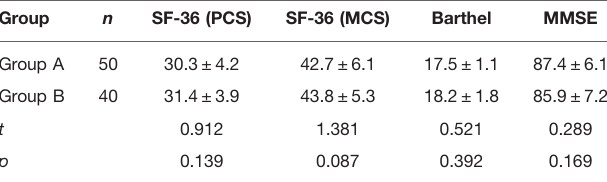
TABLE 6 | Comparison of life quality and mental state at 12 months postoperative between two group (score, (cid:1) x + S ).